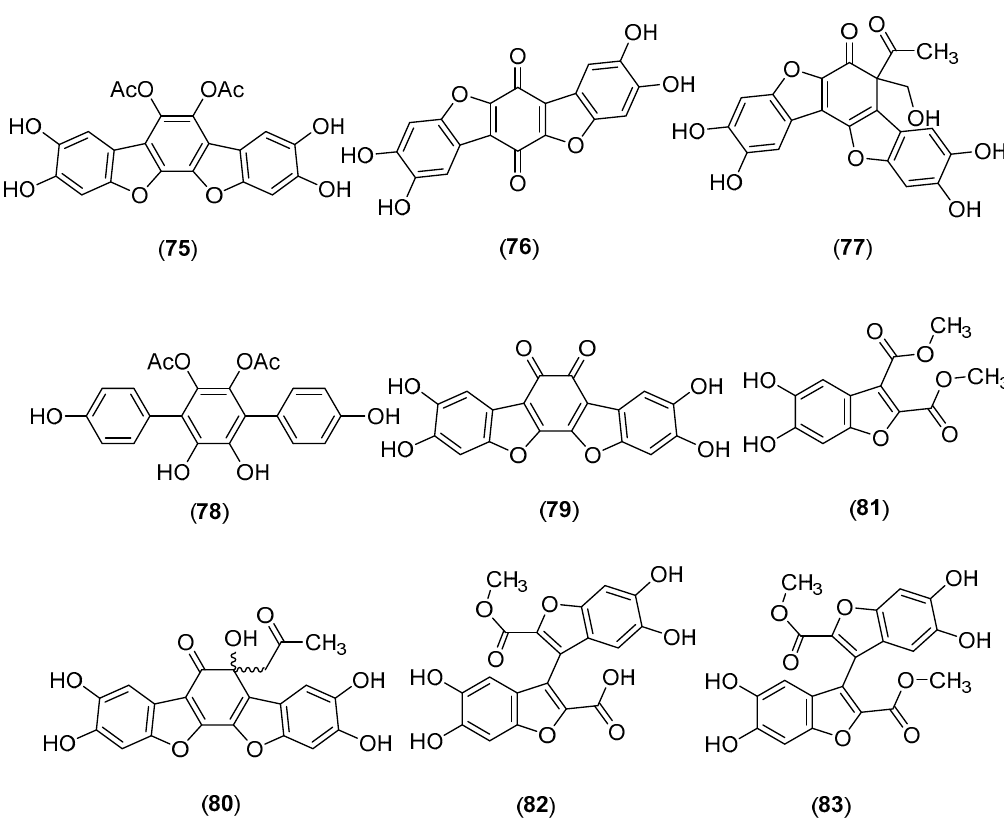
Figure 15. Chemical structures of selected compounds isolated from Polyozellus multiplex.